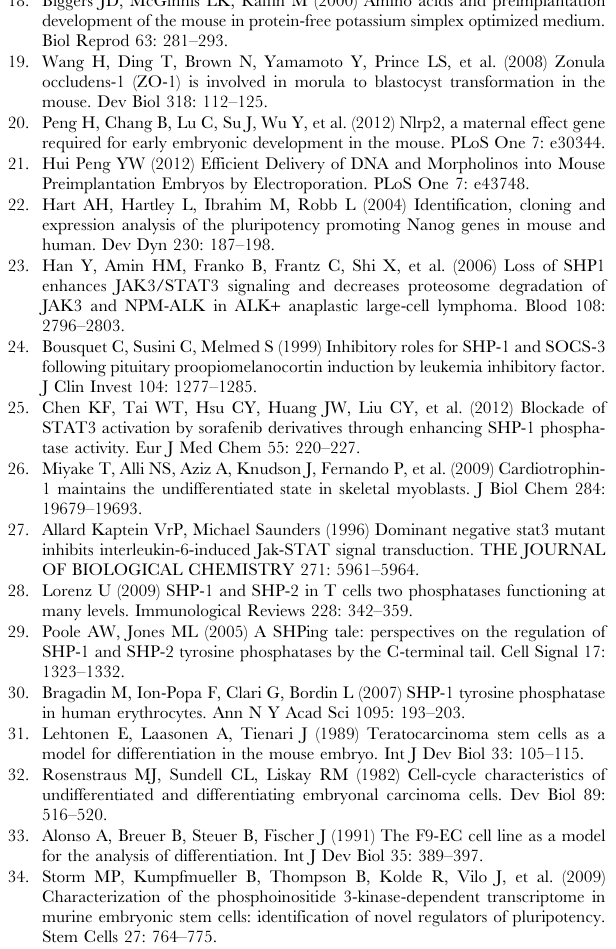
Table S1 Sequences of primers for SHP-1 and STAT3.